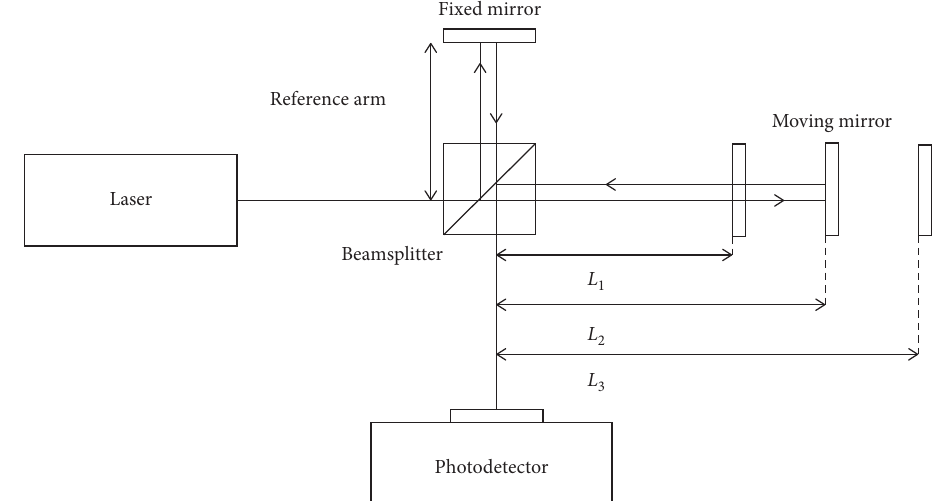
Figure 5: Illustration of the interferometer [75].